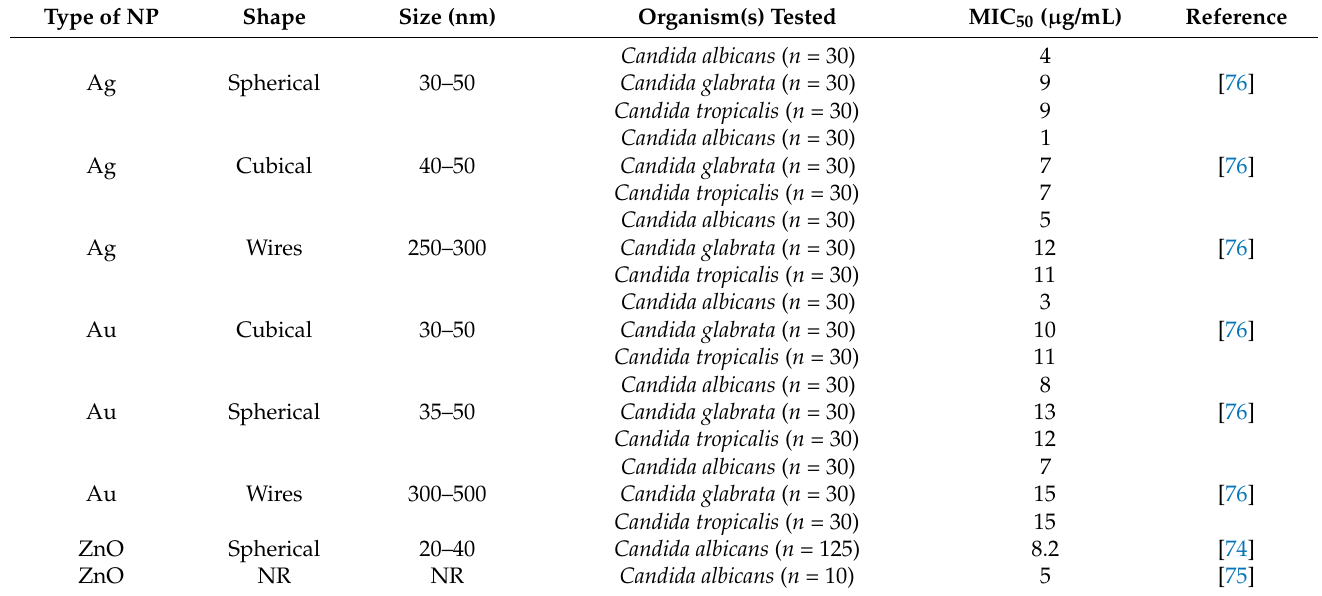
Table 2. Activities of NPs tested on different fungal species expressed as MIC 50 ( µ g/mL).